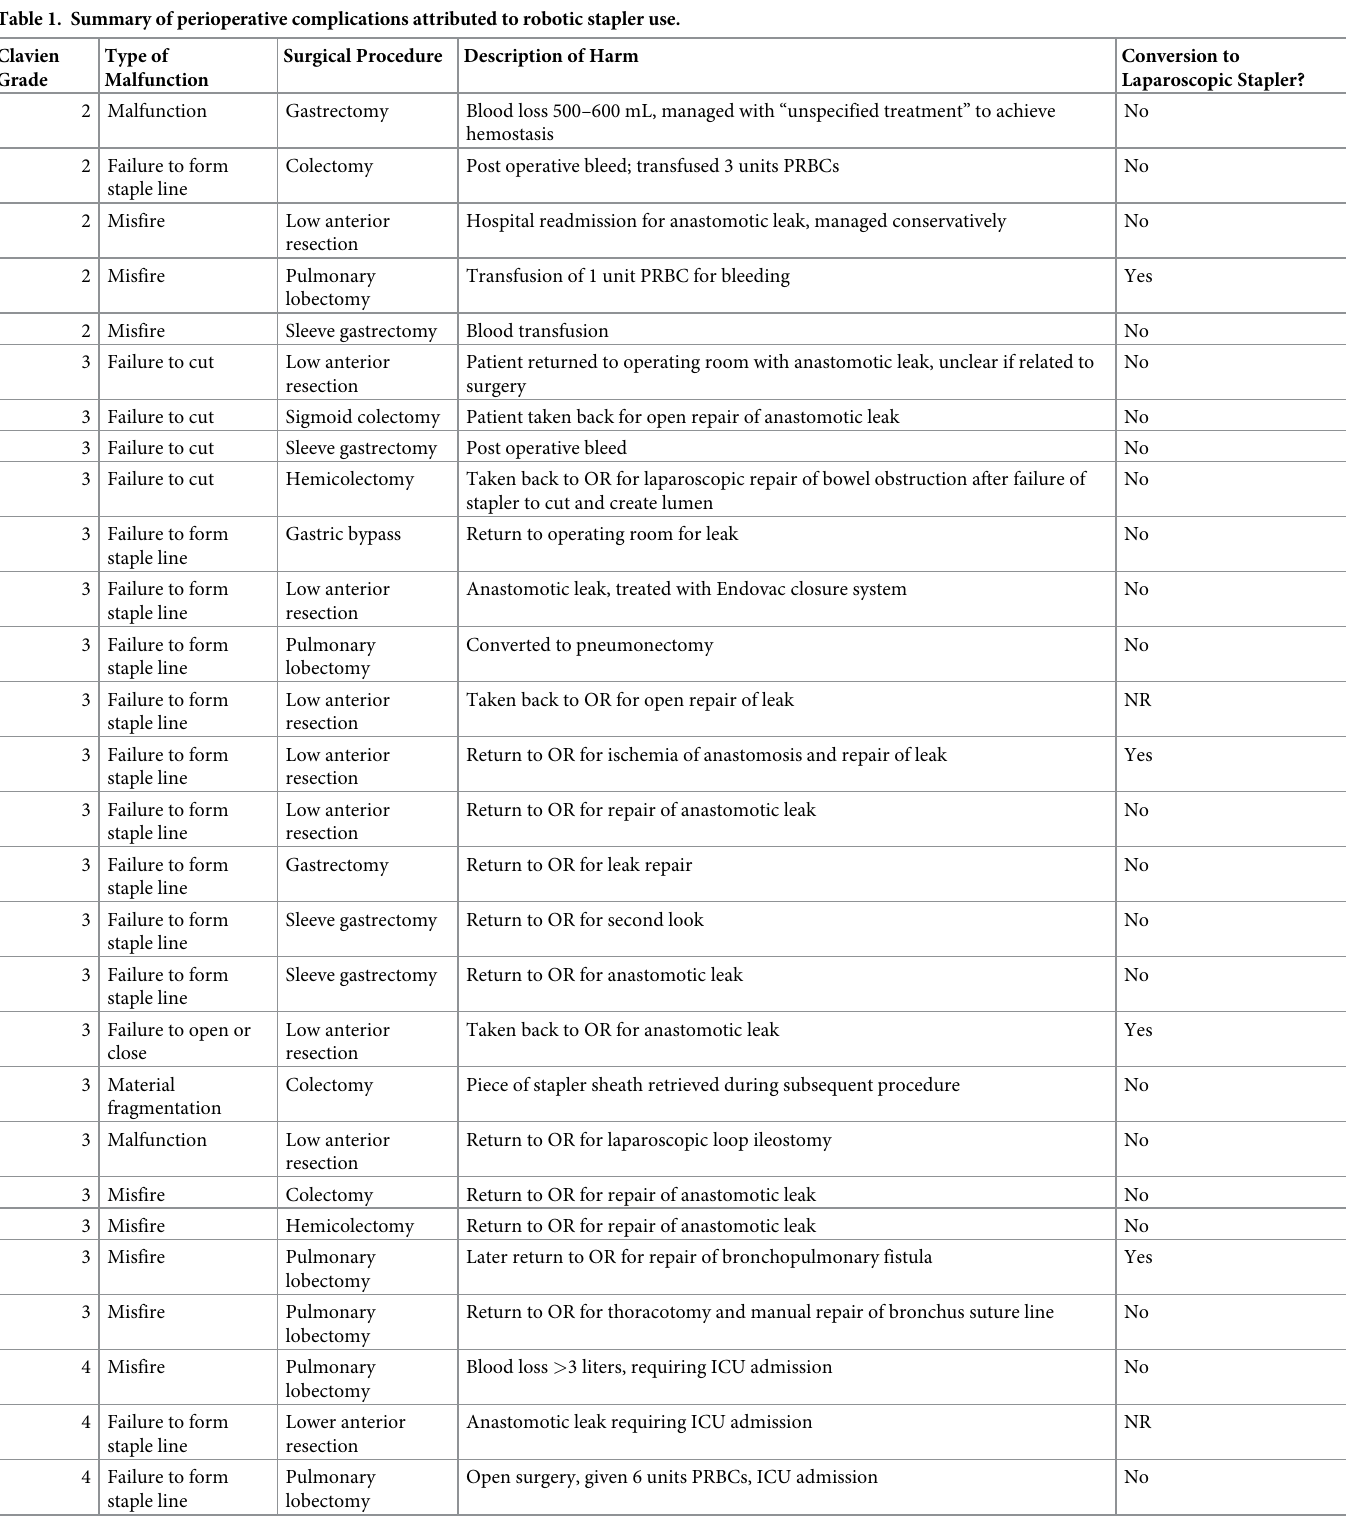
Table 1. Summary of perioperative complications attributed to robotic stapler use. Clavien